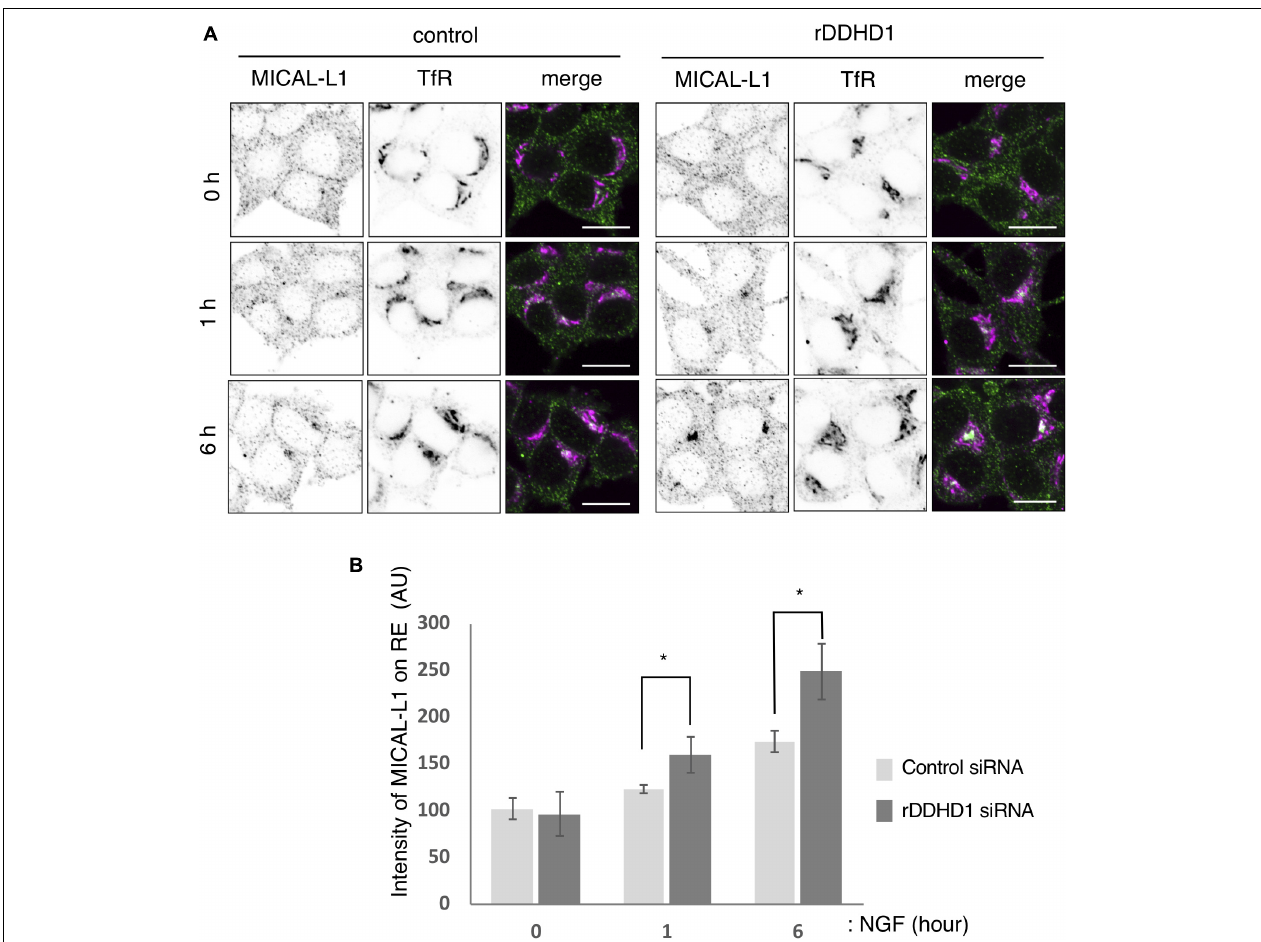
FIGURE 5 | Enhancement of MICAL-L1 recruitment to the recycling endosomes by rDDHD1 knockdown in PC12 cells. (A) At 72 h after siRNA treatment, PC12 cells were stimulated with NGF for the indicated times. The cells were fixed and stained with antibodies against TfR and MICAL-L1. Scale bars, 10 µ m. (B) MICAL-L1 signals on recycling/early endosomes (RE) visualized with anti-TfR antibodies were calculated for each period and are shown in the graph. At least 100 cells were examined in each experiment. Values are expressed as means for four independent experiments ± S.D * p < 0.05 (Student’s t test).